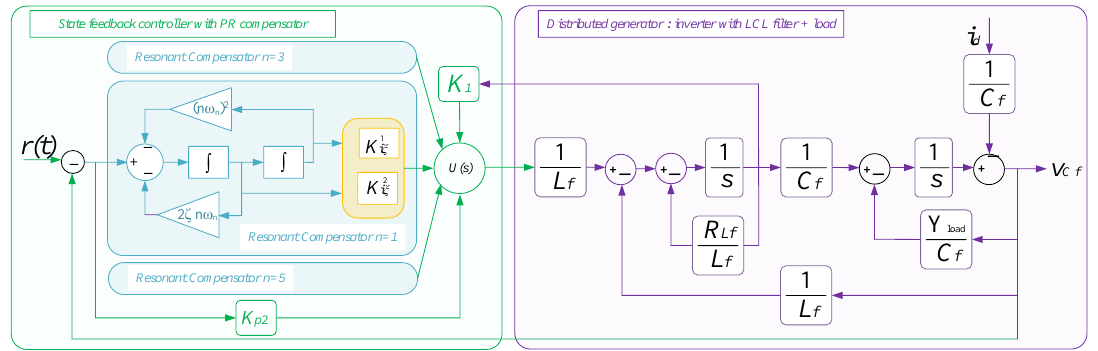
Figure 3. Block diagram of closed loop system for proportional resonant controller and inverter with LCL